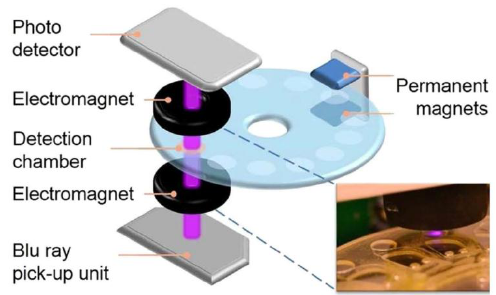
Figure 13. Sketch of the optomagnetic device incorporating Blu-ray optics introduced by Donolato et al. [239]. Reprinted with permission from [240]. Copyright 2015, Nature Publishing